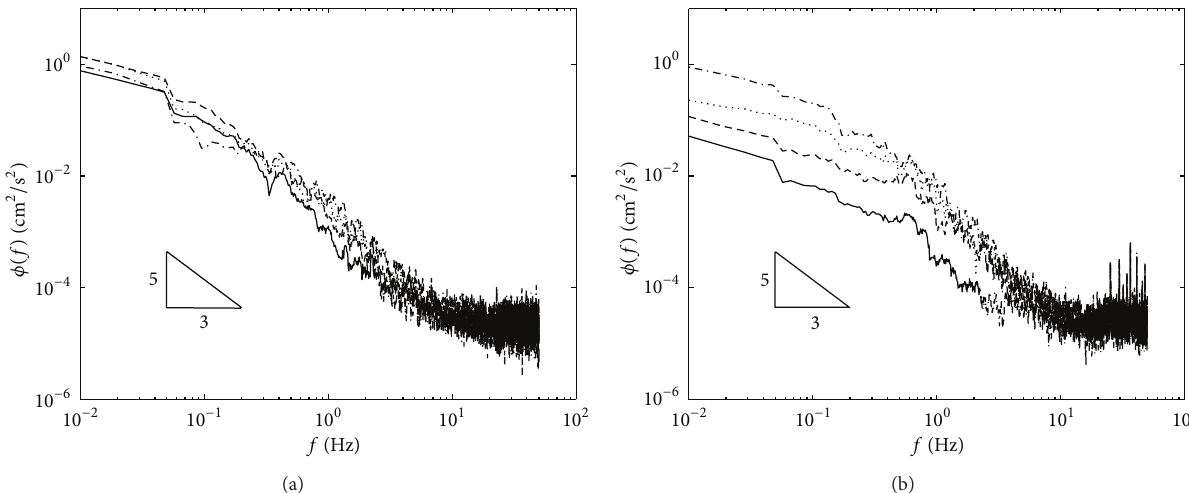
Figure 9: Plots showing the one dimensional frequency spectrum for (a) 𝜙 𝑢 (𝑓) and (b) 𝜙 𝑤 (𝑓) for a typical high 𝑅𝑒 𝑙 flow. The experiments shown correspond to 𝑅𝑒 𝑙 = 474 at 𝜉/ℓ 0 = 0.032 (solid), 0.317 (dashed), 0.634 (dotted), and 1.27 (dash-dotted). The triangle-solid shows the slope 𝑓 −5/3